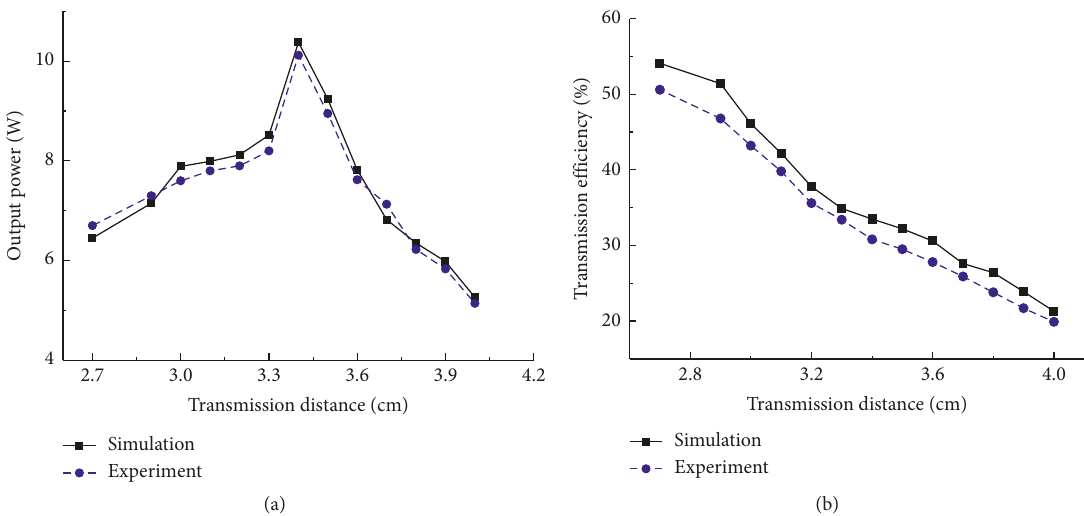
Figure 15: Transmission distance-output power and transmission distance-transmission efficiency curves.